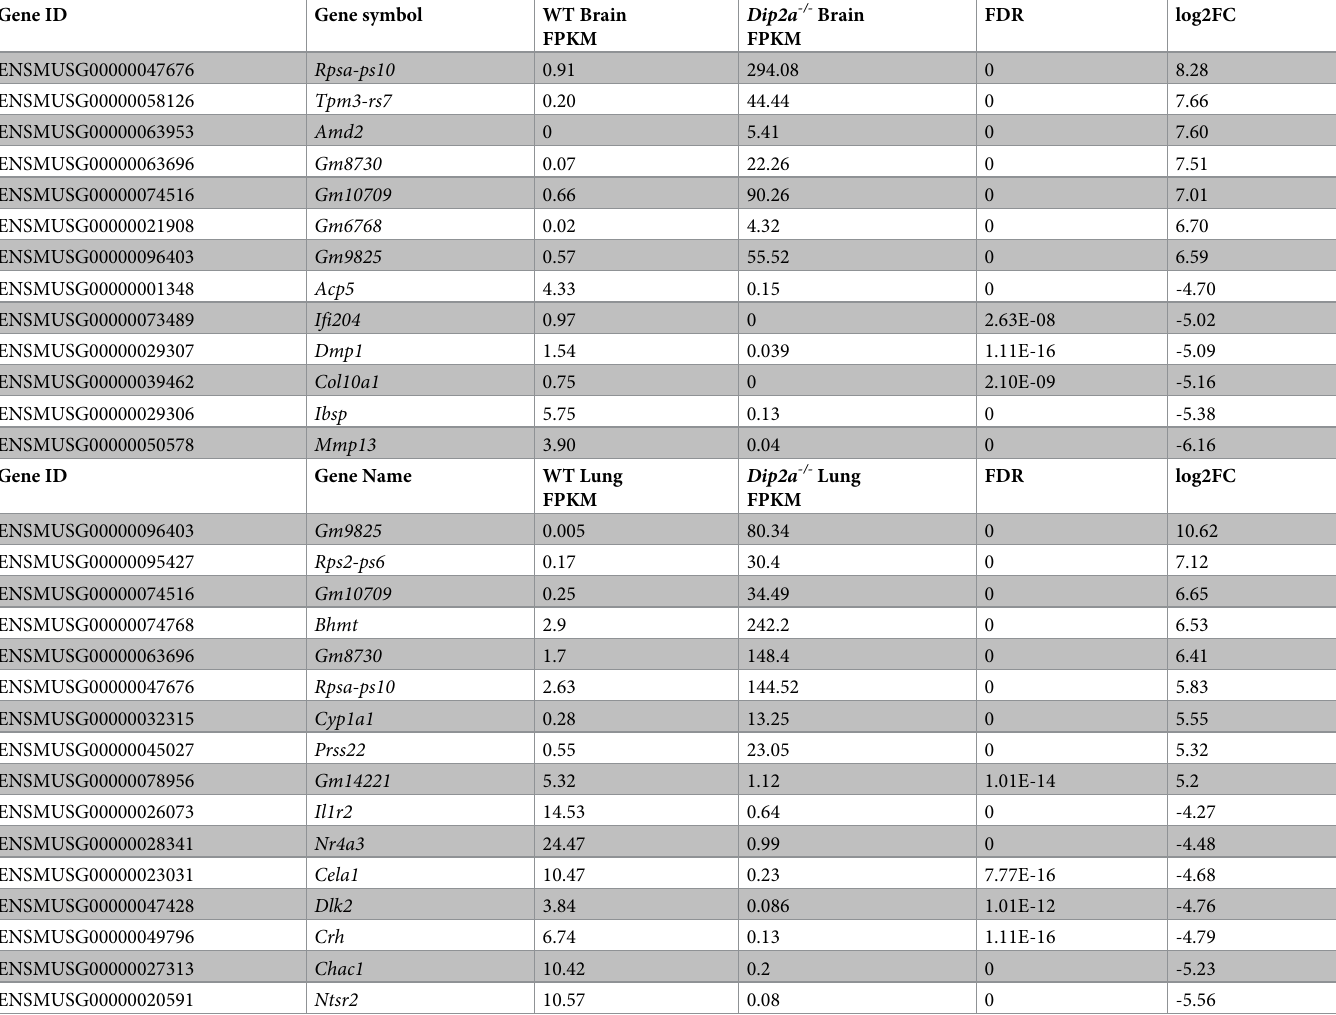
Table 2. Highly significant differentially expressed genes in Dip2a -/- group compared to Wild type group (FDR < 0.01, FC > 20). Gene